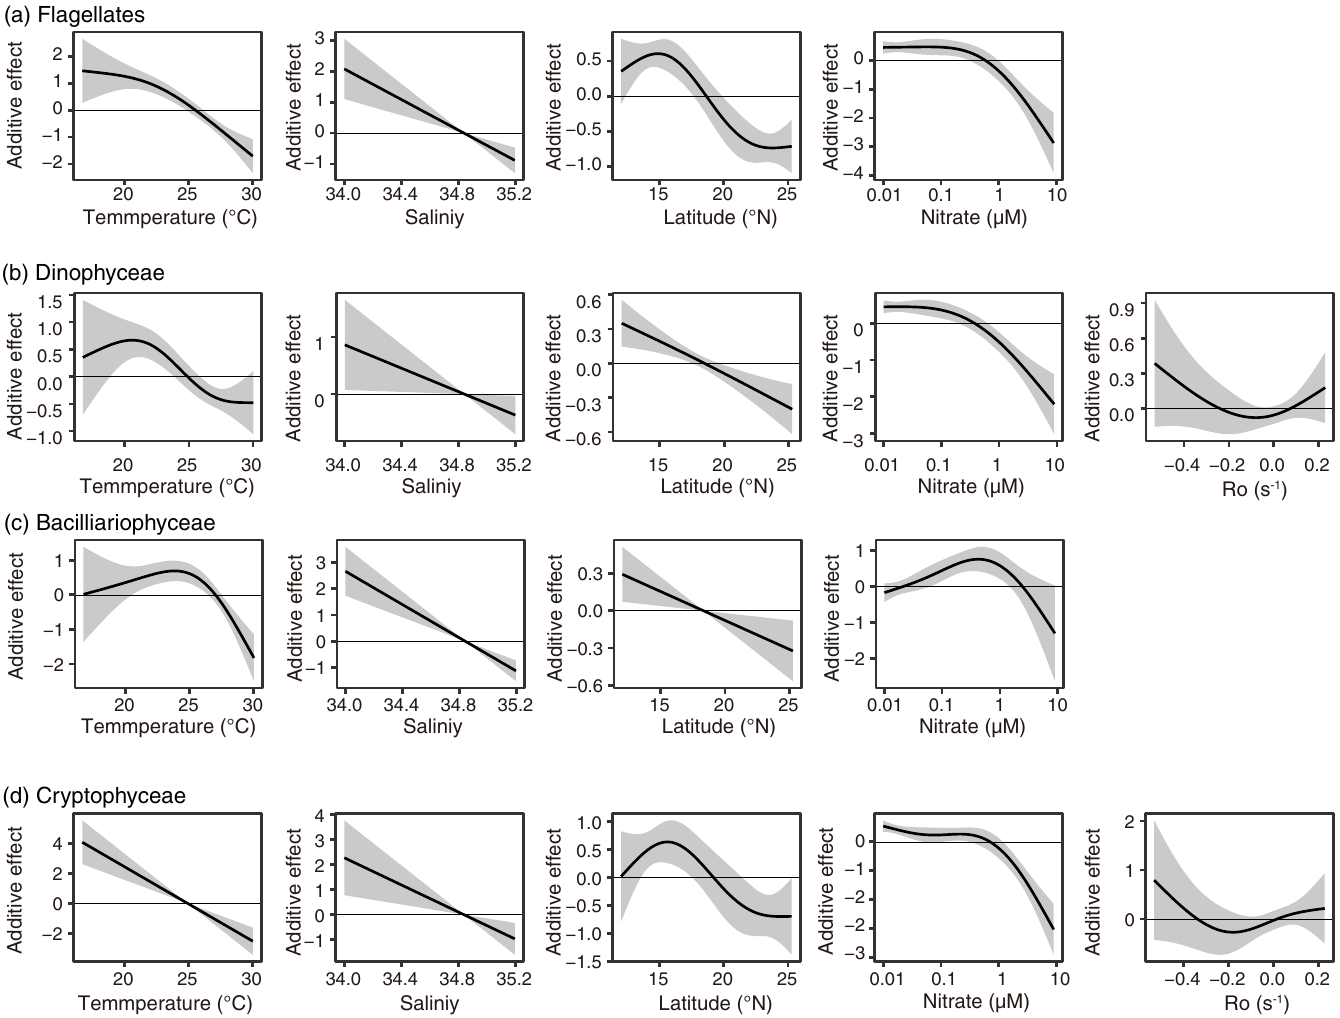
Fig 6. Partial effects of GAMs on (a) flagellates, (b) Dinophyceae, (c) Bacillariophyceae, (d) Cryptophyceae. The black lines are the smoothing terms, and shadows denote the 95% confidence intervals. The blank panels denote the parameters that were not selected in using the AIC selection. https://doi.org/10.1371/journal.pone.0250604.g006 varied significantly with the assemblages summarized in Axis 1 and 2 of class-level PCoA ( p < 0.05); however, the other parameters (i.e., salinity, latitude, and Ro) were not significant. Axis 1 explained 57.6% of variations and Axis 2 explained 18.7% of variations, denoting that positive values were warm and low nitrate concentrations (Fig 8). The weighting average score of every class denoted that two rare classes, Haptophyceae (Hap) and Euglenophyceae (Eug), differed from the other classes (Fig 8). The other classes were plotted in similar positions and their score was positive along Axis 1. Along Axis 2, Cyanophyceae (Cya) and Dictyochophy- ceae (Dic) were scored positive, but the other classes, i.e., Bacillariophyceae (Bac), Dinophy- ceae (Din), Prasinophyceae (Pra), Cryptophyceae (Cry) and flagellates (Fla), were scored negative. The 95% ellipse of every sampling layer based on site scores of class-level PCoA denoted that plots of clusters of sites scored at the 200 m depth layer differed slightly from the that of other layers. In addition, the site scores at 10 m depth layer varied most widely (Fig 8). The sample scores of the PCoA of the Dinophyceae showed the Dinophyceae community at 200 m depth differed from others, as well as the other PCoA (Fig 8). On the other hand, the